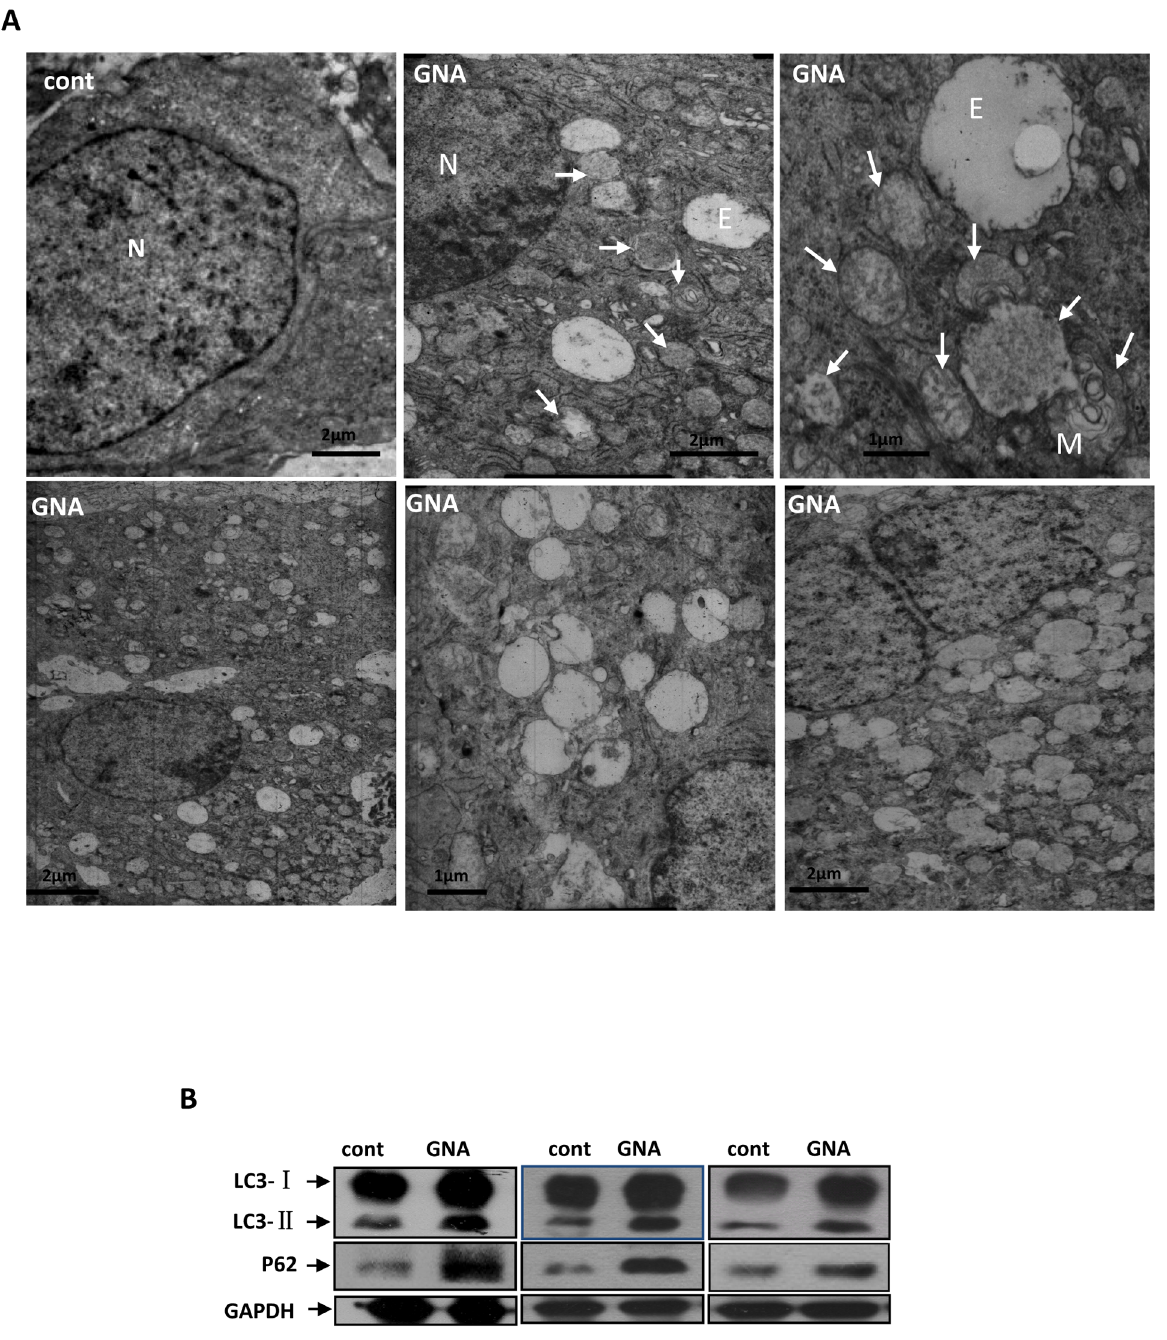
Figure 7. GNA inhibited autophagy in vivo. A549 cells were injected s.c. (2 6 10 6 /mouse) into 30–40-day-old BALB/cA male nude mice. After established tumors had formed ( , 50 mm 3 ), the mice were i.v. injected with or without 16 mg/kg GNA twice a week for three weeks. At 24 hours after the last i.v. injection, the mice were sacrificed and the tumors were removed. A, Representative electron microscopy images obtained from the tumors. N, nucleus, E, empty vesicle, M, membranous body. Arrows indicate autophagosomes with contents. B, After preparing tissue homogenate from the tumors, the LC3 and p62 levels were analyzed by western blotting. The results shown are representative of at least 3 independent experiments. doi:10.1371/journal.pone.0083604.g007 endogenous Beclin 1 compared with cells transfected with control knockdown cells displayed significantly less cell death compared to siRNA, indicating that the Beclin 1 siRNA is efficient (Figure 5A). control cells (Figure 5B), suggesting that GNA-induced cell death is After 24 or 36 hours treatment with 3 m M GNA, Beclin 1 related with dysfunctional autophagy.